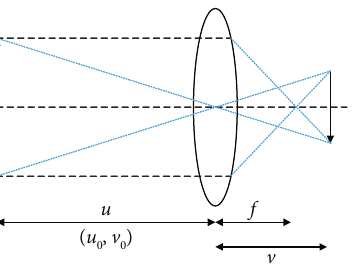
Figure 4: Keyhole imaging diagram.